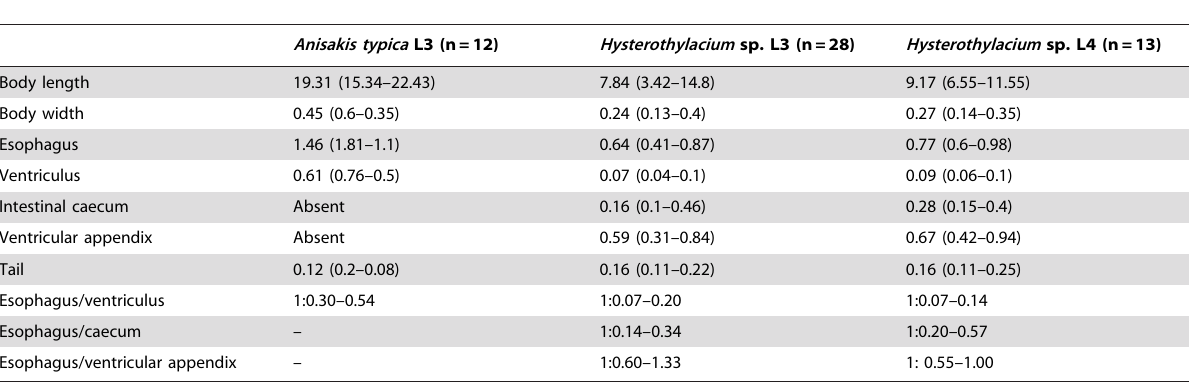
Table 1. Present measurements of Anisakis typica and Hysterothylacium